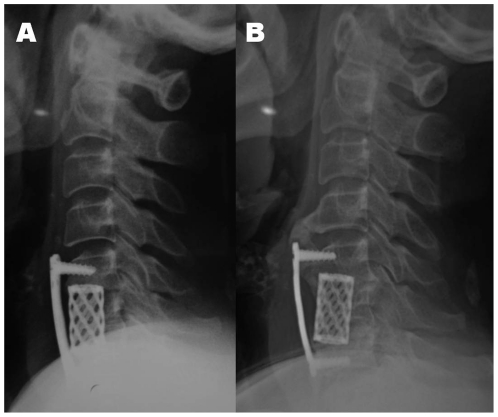
A 52-year-old female who underwent 1-level corpectomy and TMC fusion.
2A. Postoperative lateral X-ray on the second day after operation showed detectable gap between anterior plate and upper vertebral body. 2B. Postoperative lateral X-ray at the 5-year follow-up showed noticeable screw loosening at the upper vertebral body and spontaneous fusion of heterotopic ossification at the adjacent level.